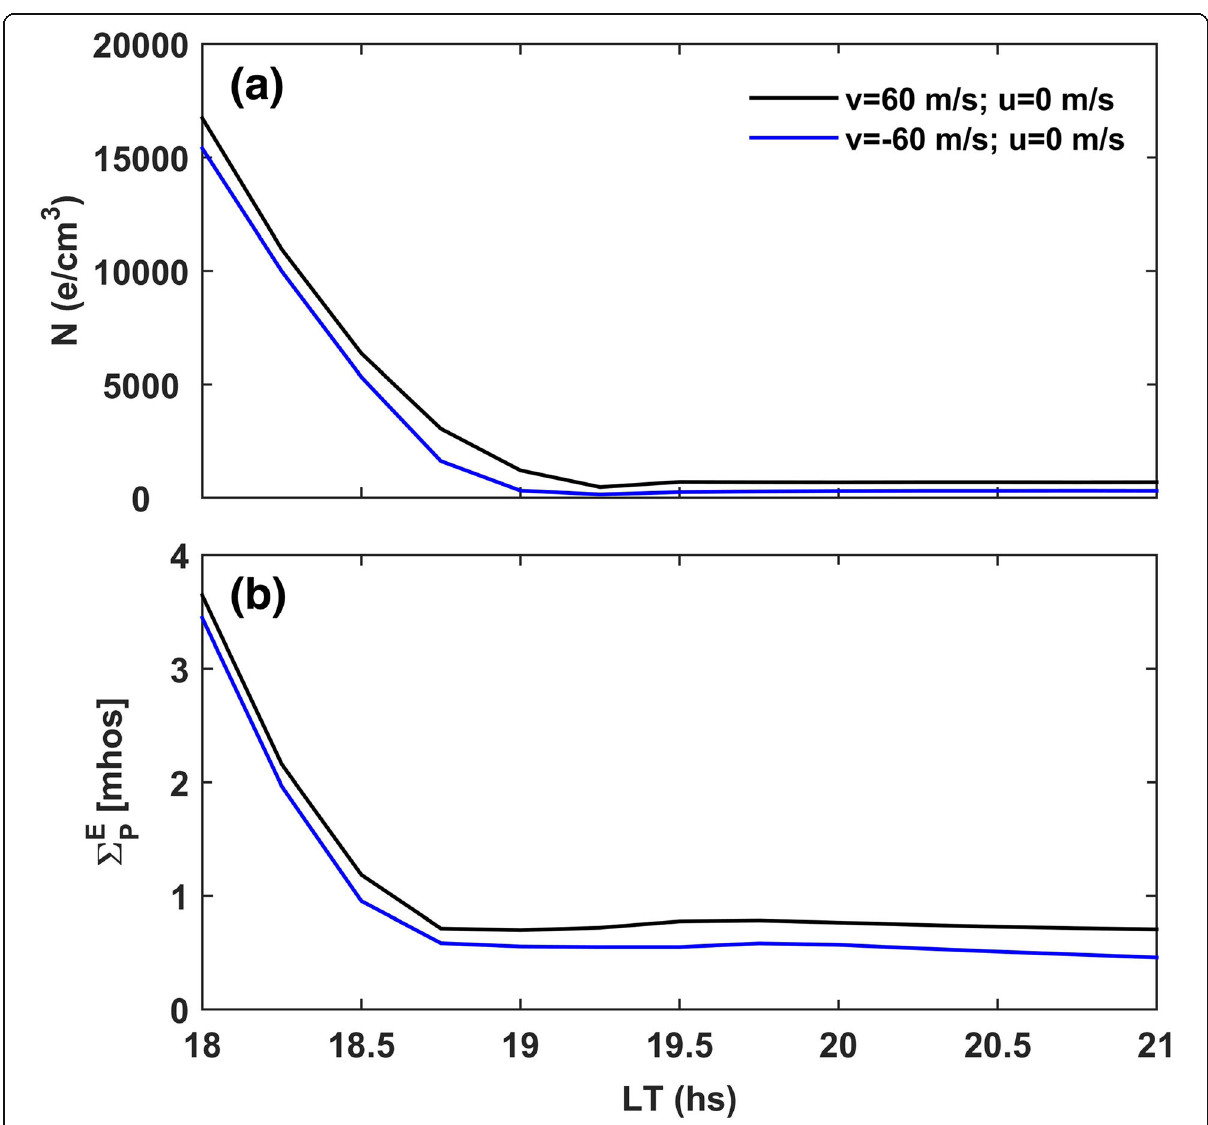
Fig. 7 The local time variations of off-equatorial (10° N dip latitude) E-region (125 km) electron density ( a ) derived from the controlled SAMI2 simulations with meridional wind (V) set to − 60 m/s (equatorward) and + 60 m/s (poleward); while the zonal wind (U) set to zero for both cases. b The total field-line-integrated E-region (90 to 150 km) Pedersen